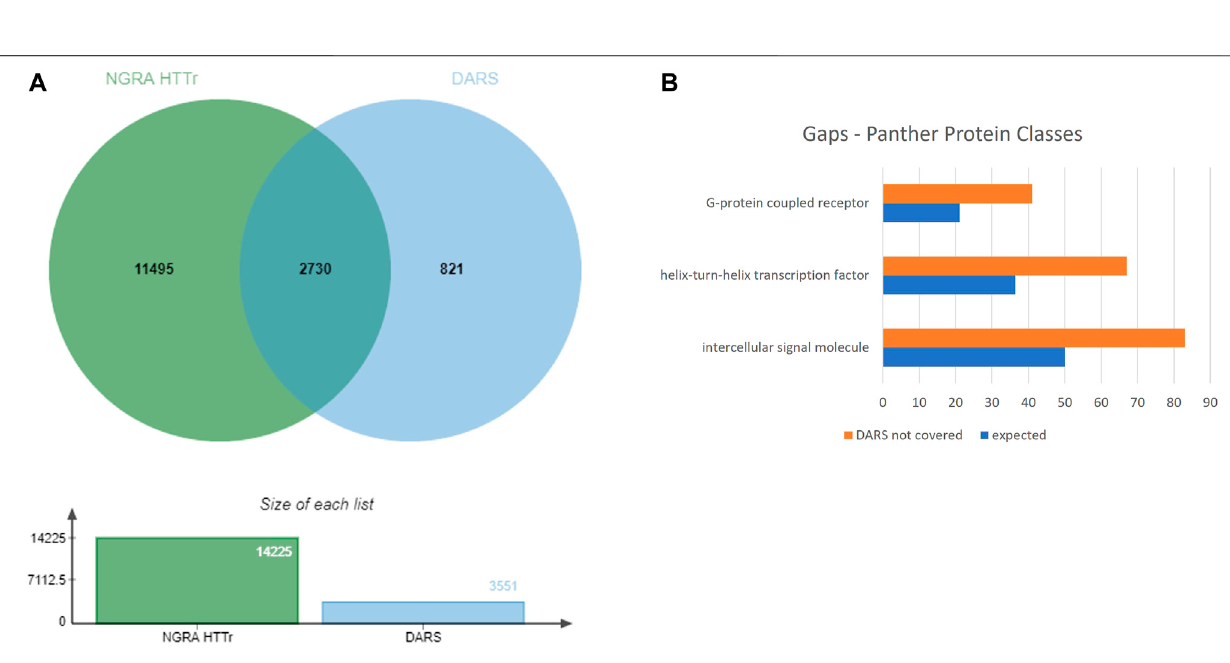
Frontiers in Toxicology |